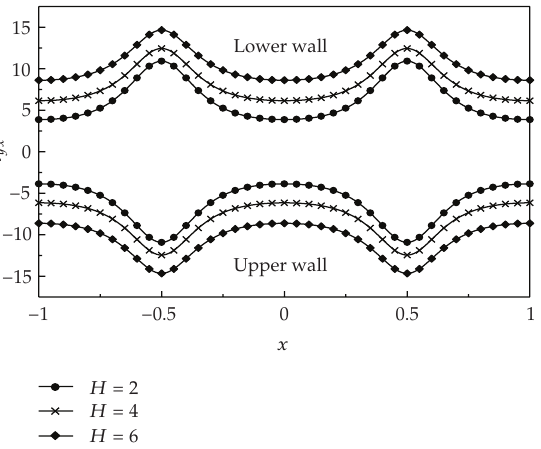
Figure 5: The shear stresses τ yx for α (cid:8) 0 . 5 , θ (cid:8) 1 . 2 , m (cid:8) 3 , N (cid:8) 0 . 6, and di ff erent values of H .